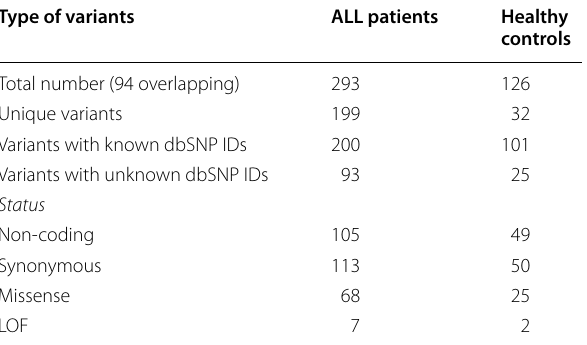
Table 2 Classification and number of variants in patients and